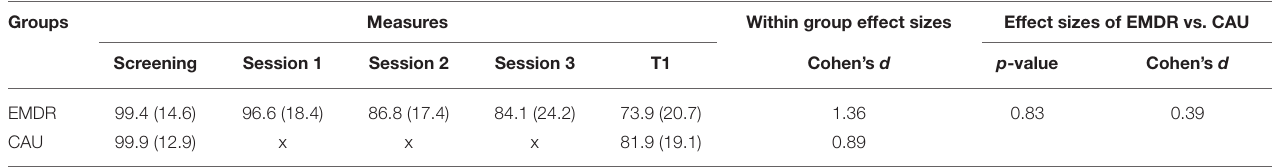
TABLE 2 | WDEQ-A scores (mean ± SD) at baseline (screening), sessions, and posttreatment (T1) in the EMDR therapy ( n = 58) and CAU group ( n = 52), within-group and between-group effect sizes. Groups Measures Within group effect sizes Effect sizes of EMDR vs. CAU Screening Session 1 Session 2 Session